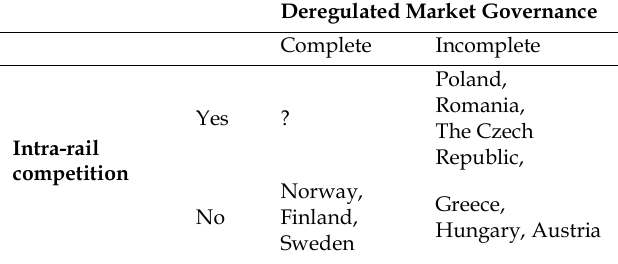
Table 1. Completeness of market deregulation and occurrence of intra-modal competition in the countries